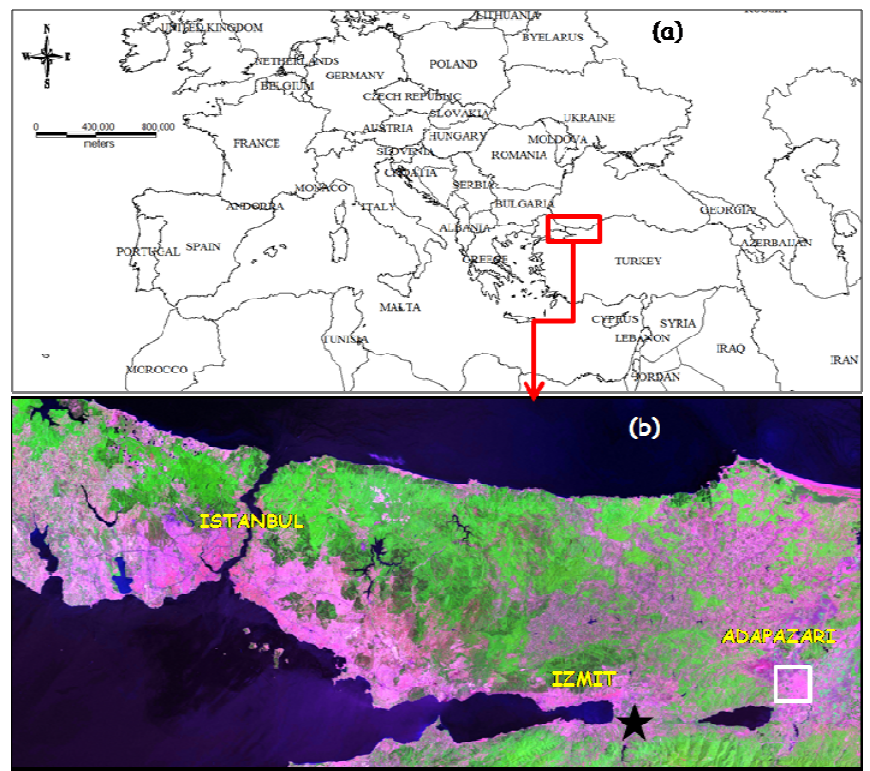
Figure 1 . Location of the study area, (a) Turkey and surrounding countries, (b) Marmara Region, star shows the epicenter of the